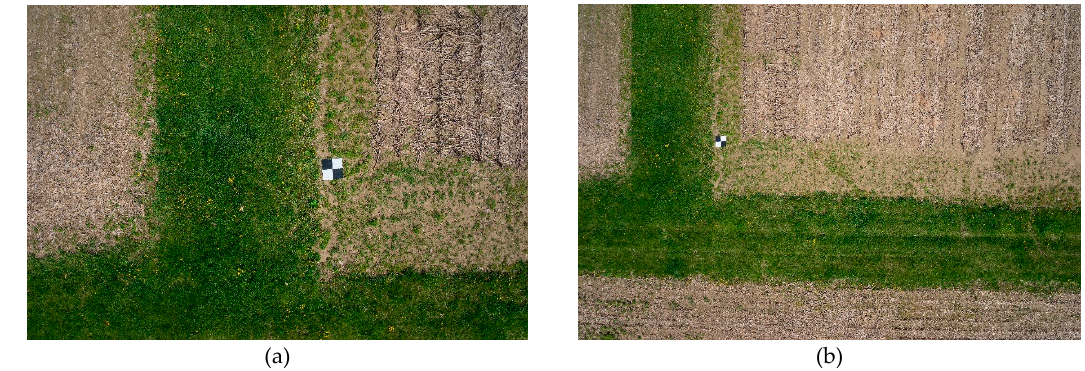
Figure 14. Sample images captured by the Sony RBG sensor over the calibration test field. ( a ) 20m flying height and ( b ) 40m flying height.